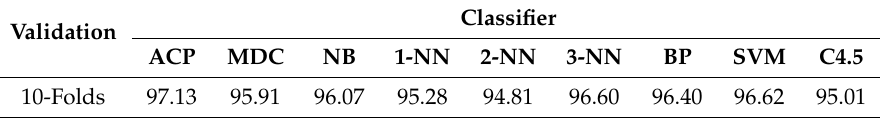
Table 3. Summary of classification results for 10-fold cross